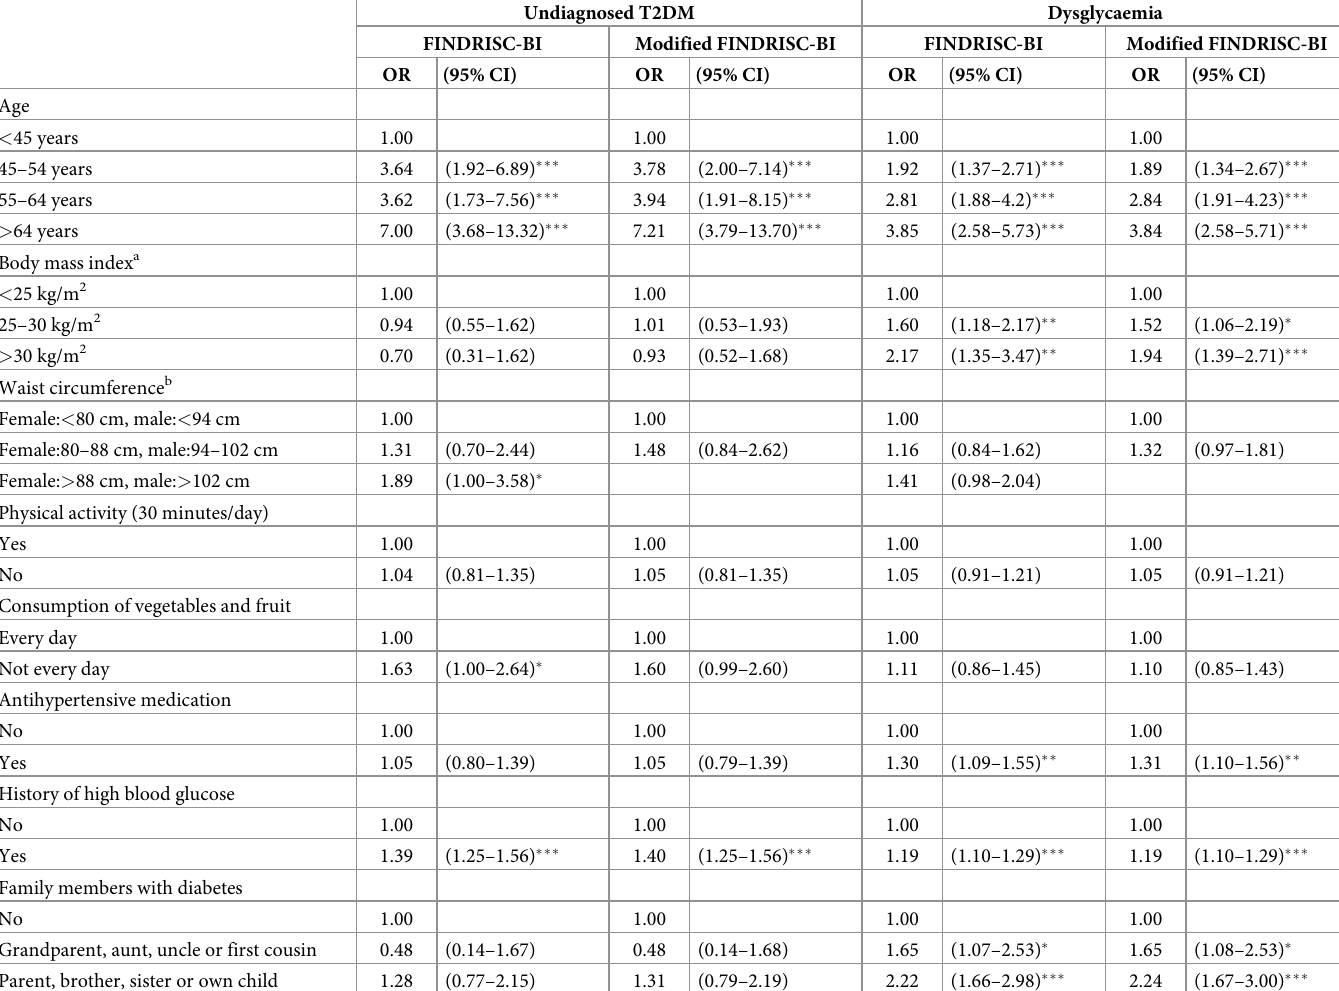
Table 3. Multivariate logistic regression model of association between the FINDRISC-BI and Modified FINDRISC-BI, and undiagnosed T2DM or dysglycaemia in total participants (n = 1,403). Undiagnosed